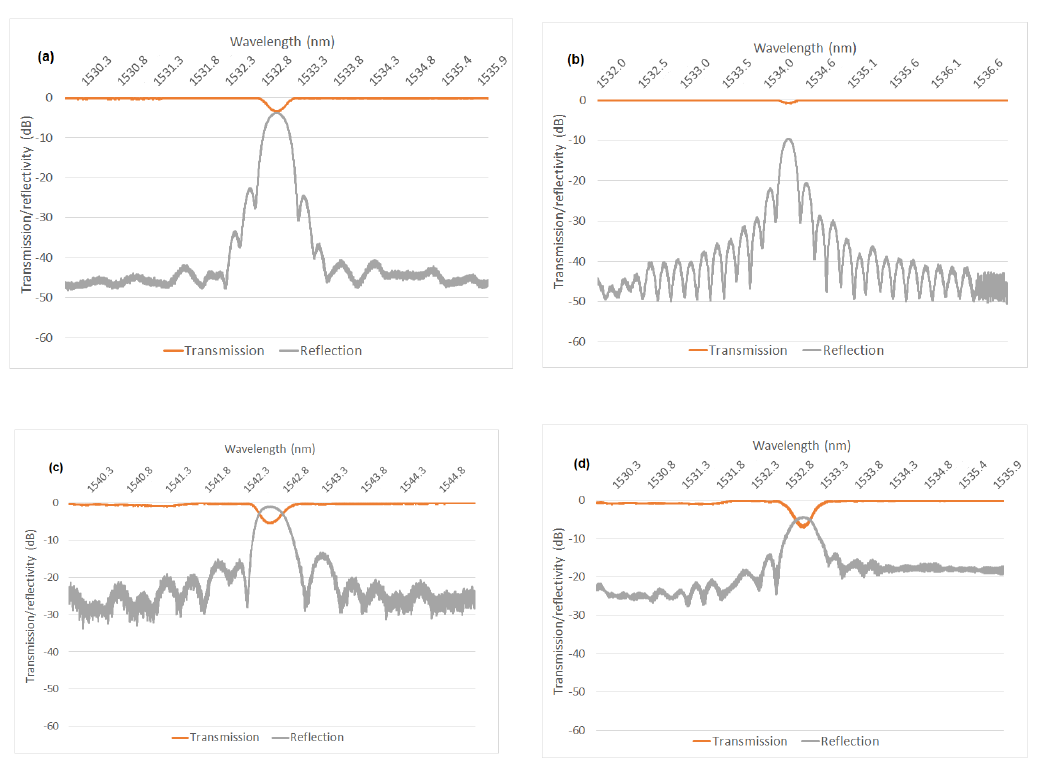
Figure 10. Example transmission and reflection spectra for each type of the FBG sensor. ( a ) Stripped and recoated gratings. ( b ) Draw tower gratings. ( c ) Trans-jacket gratings supplied by research provider. ( d ) Trans-jacket gratings from commercial suppliers.